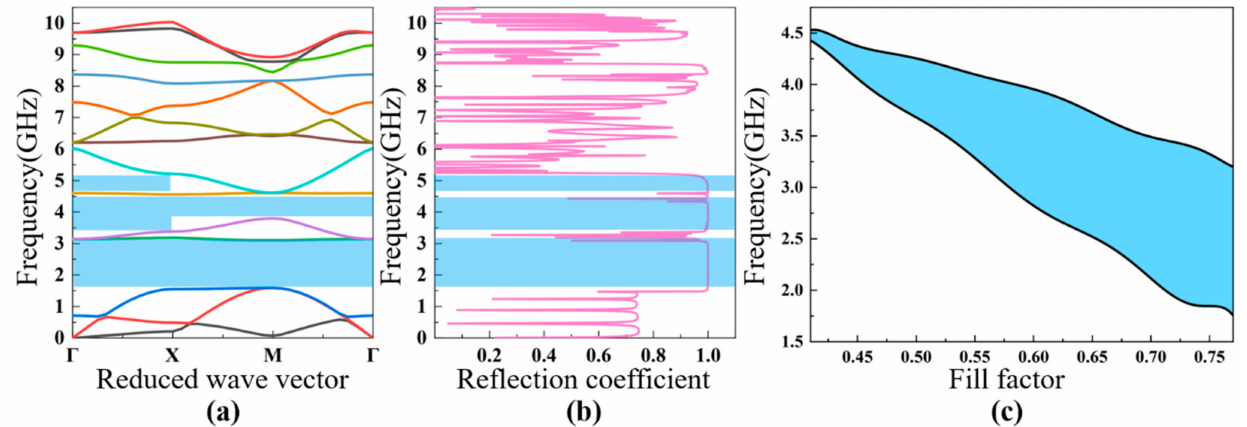
Figure 4. The calculated bandgap diagram ( a ) and reflection coefficient ( b ) of the square lattice PhC with the lattice = 0.44 µ m. The dependence of the width of the bandgap on the fill factor ( c ). parameters of a = 0.9 µ m, d 2